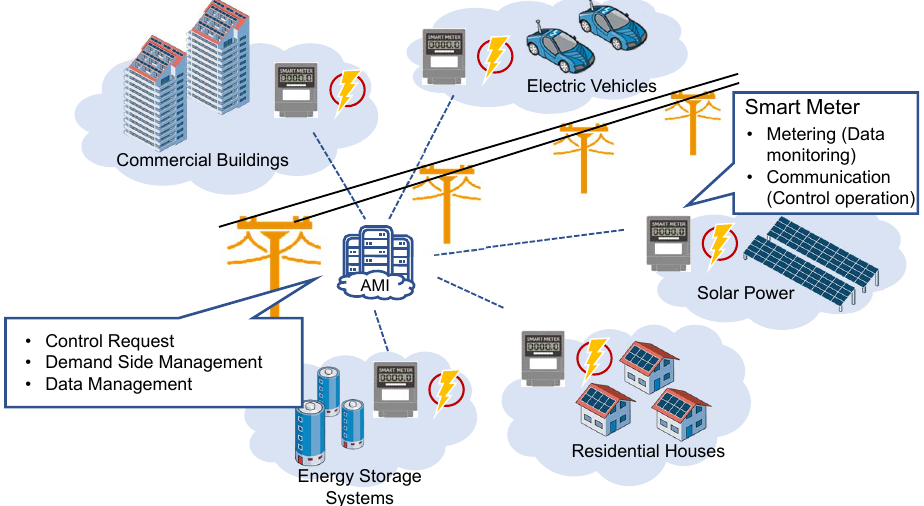
Figure 4. Smart metering configuration and